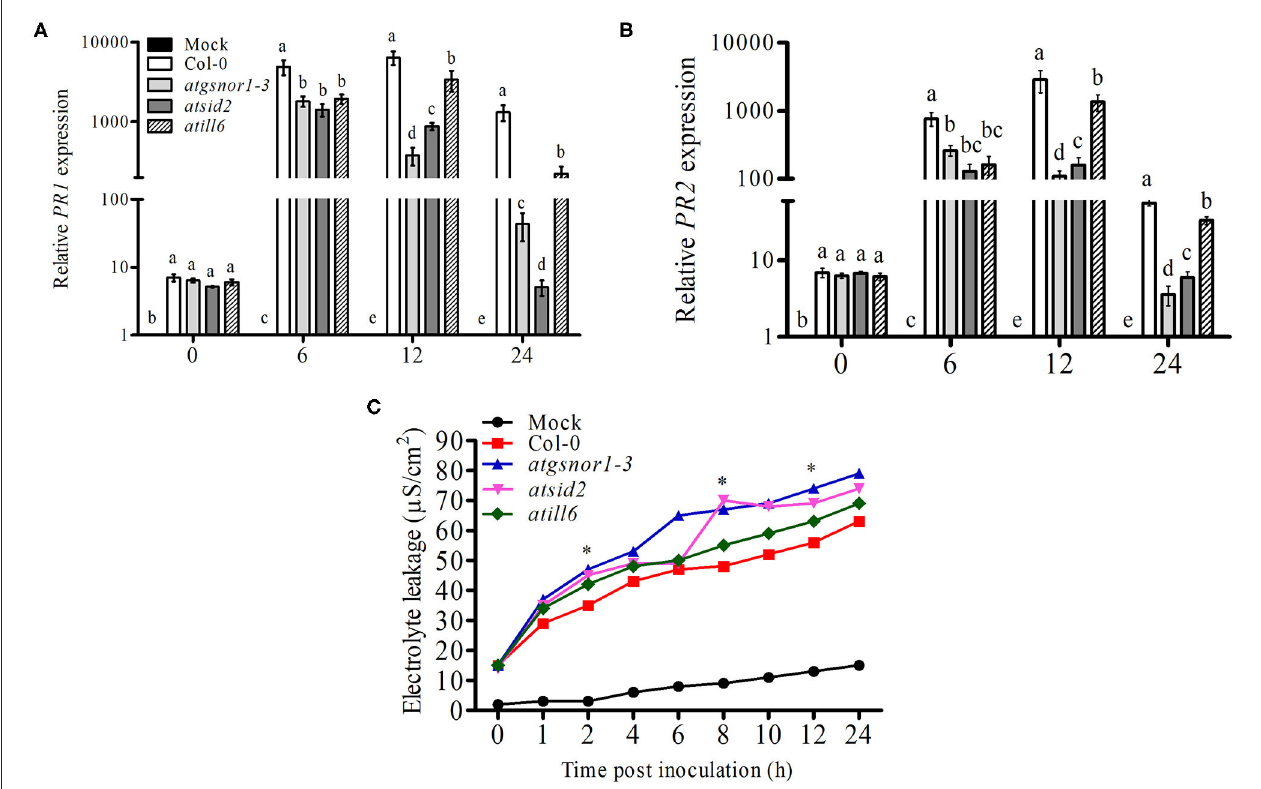
FIGURE 3 | ATILL6 positively regulates plant R-gene-mediated resistance. (A,B) Relative gene expression of PR1 and PR2 genes and (C) electrolyte leakage in the indicated genotypes after inoculation with Pst DC3000 avirulent bacteria. All data points are the means of three replicates, and error bars represent ± standard error. The significant difference between the treatments is represented by (a, b, c, d, e), one-way ANOVA analysis of varience, followed by Duncan’s multiple range test using statistical analysis system (SAS